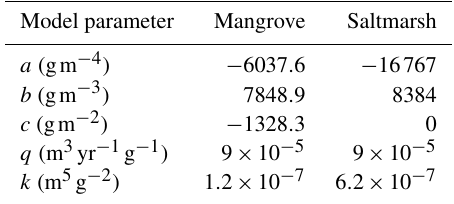
Table 1. Parameters of the soil surface elevation model. Model